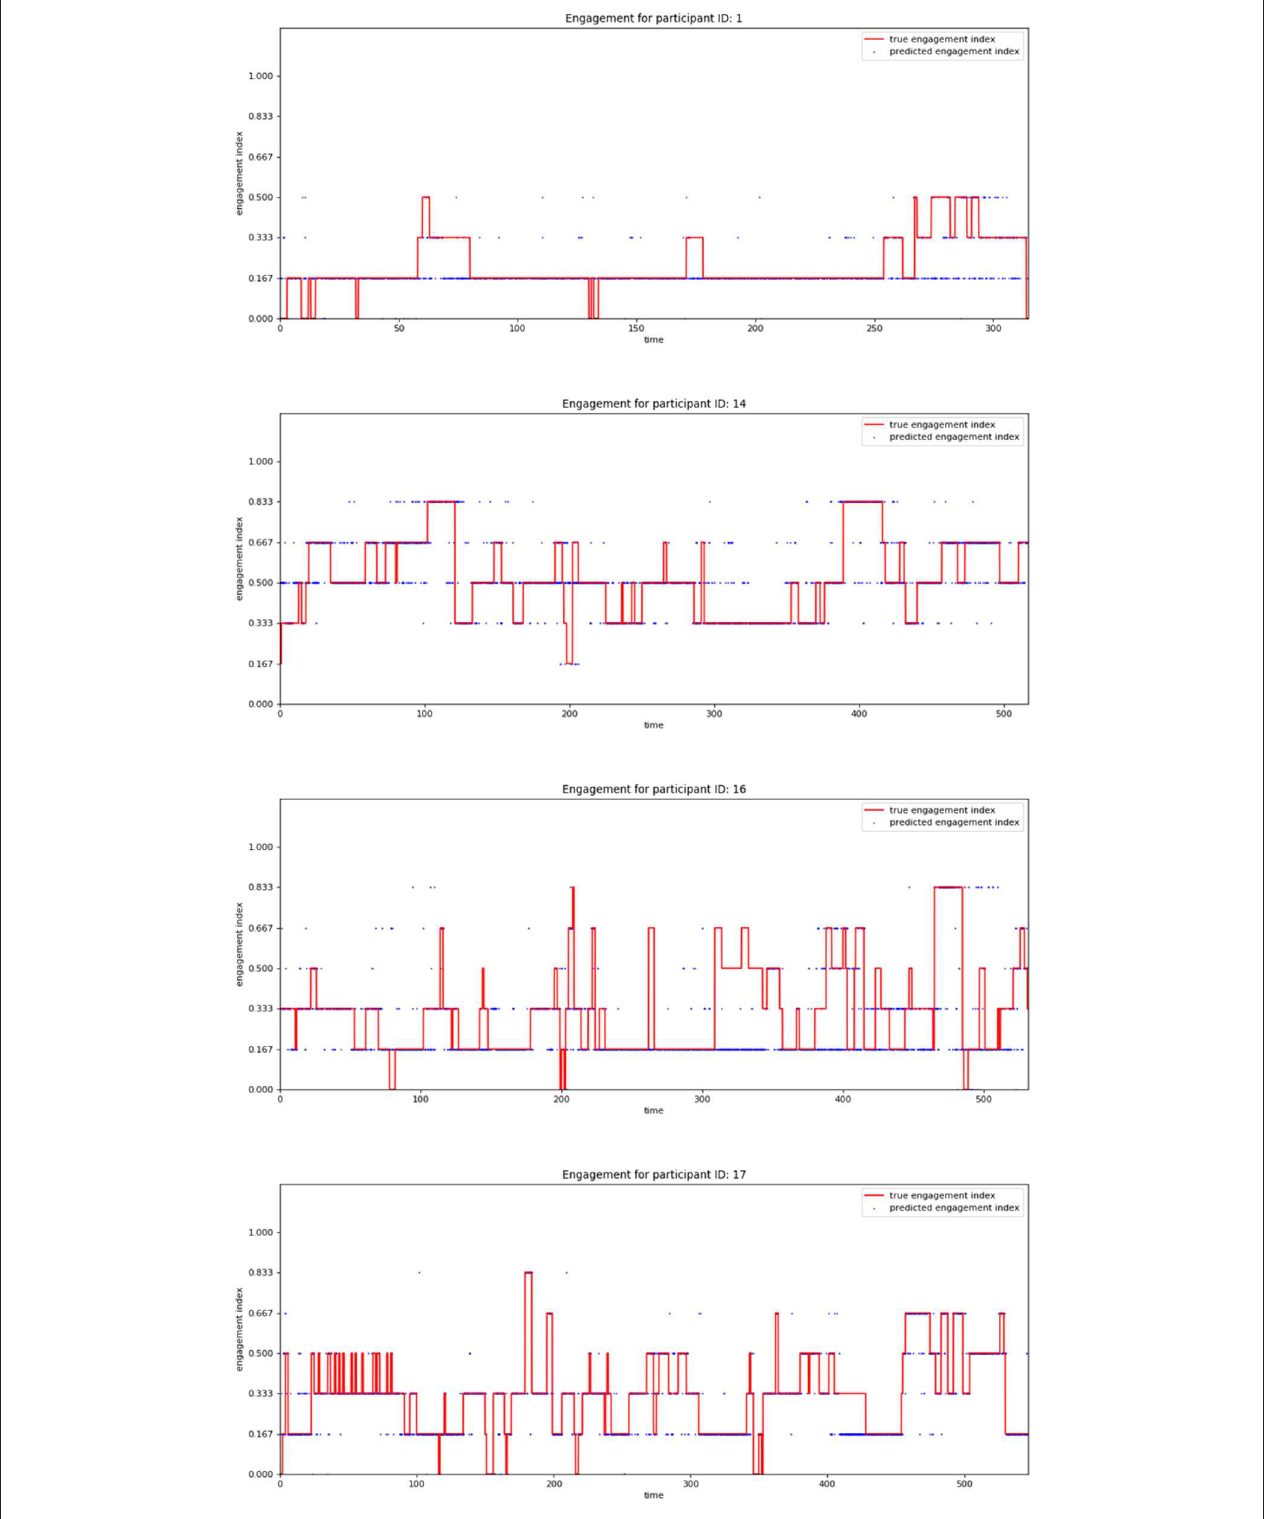
FIGURE 9 | Classifier accuracy and loss for training and test datasets for three grouped conditions.